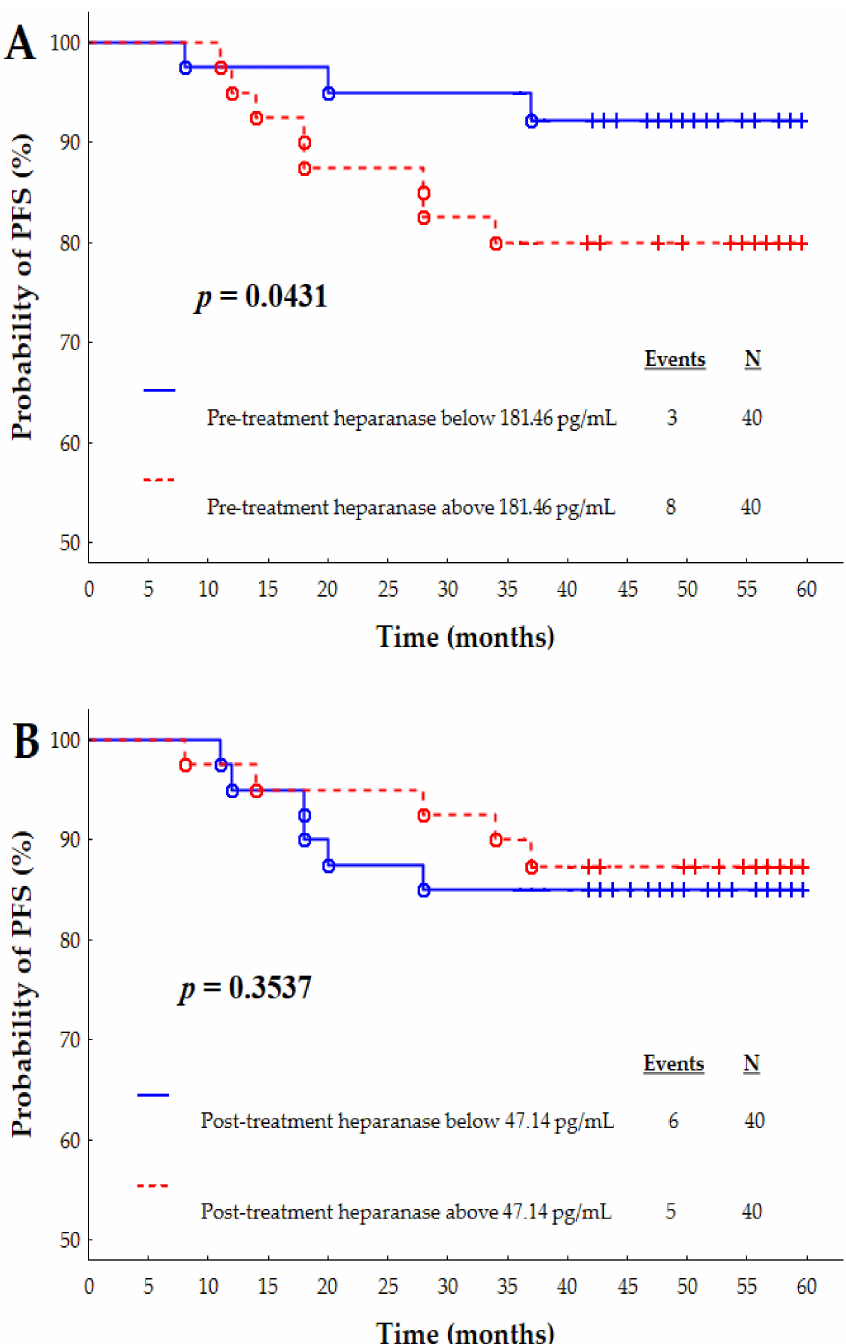
Figure 2. Kaplan-Meier survival curves depending on pre-treatment ( A ) and post-treatment ( B ) heparanase concentrations. The pre-treatment and post-treatment cut-offs for heparanase were set at 181.46 pg/mL and 47.14 pg/mL,